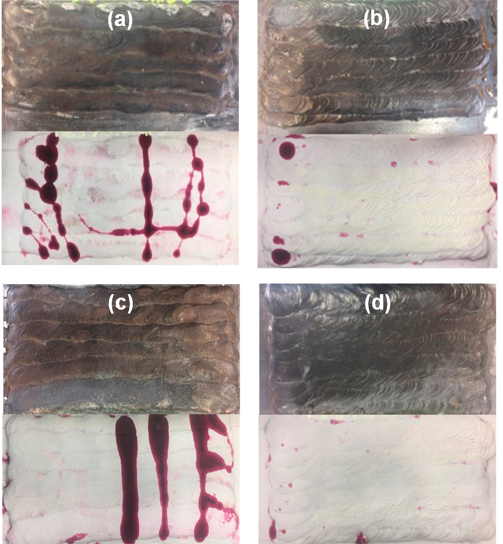
Figure 1. Visual (upside) and penetrant (downside) testing results of hardfacing specimens: ( a ) S1 (without pre-heating), ( b ) S2 (with pre-heating), ( c ) H1 (without pre-heating), and ( d ) H2 (with